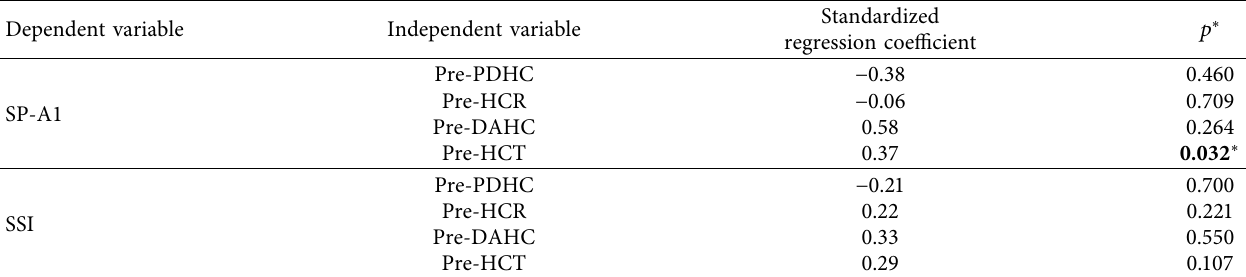
Table 5: Multiple line regression analysis of corneal stifness and highest concavity